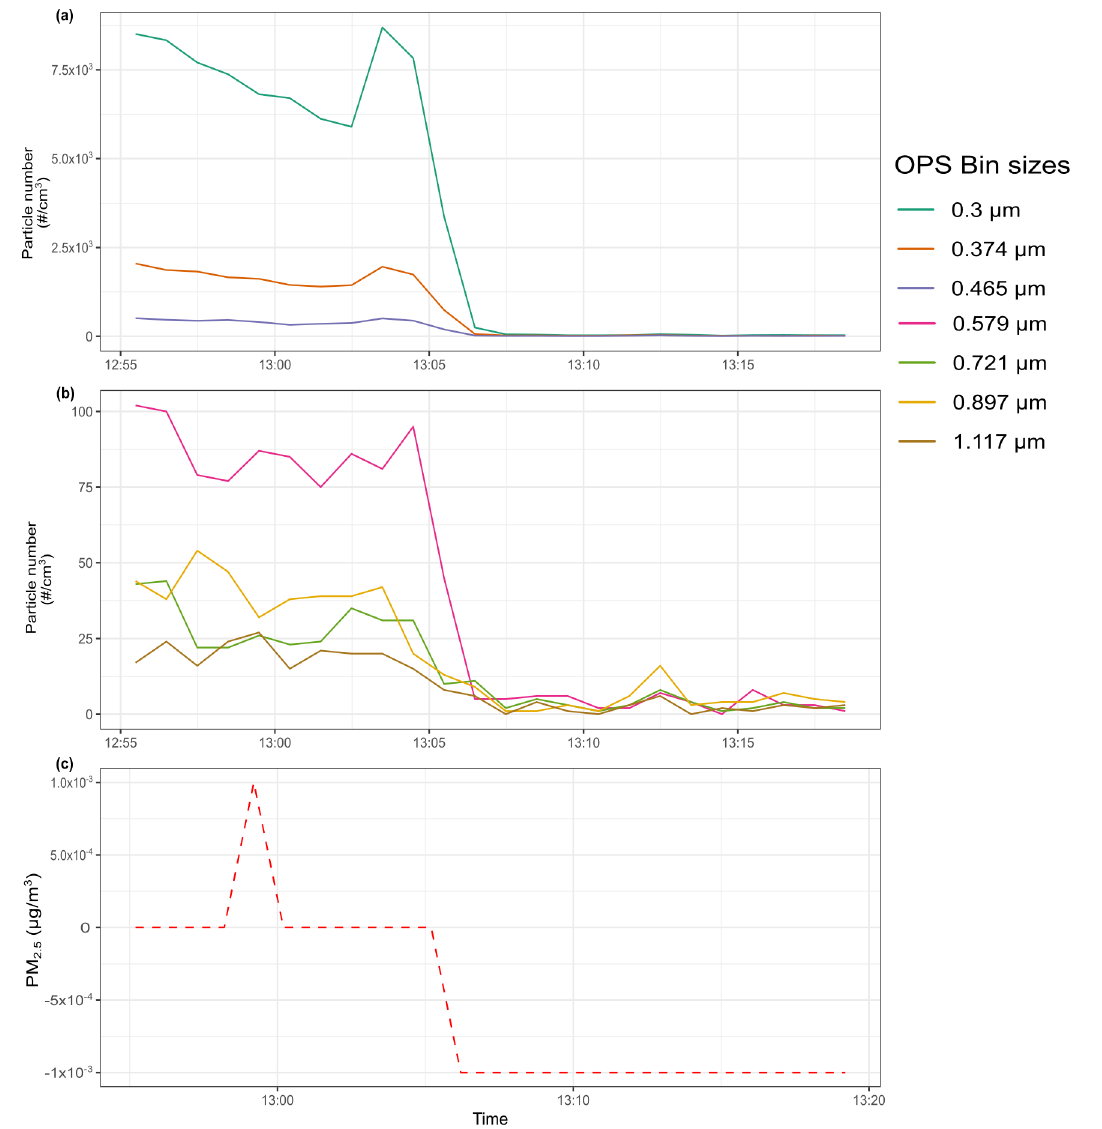
Figure A3. Measurements taken from ( a , b ) the OPS and ( c ) the DustTrak taken during the blank experiment. The ESP was turned on around 13:06 and left running throughout the